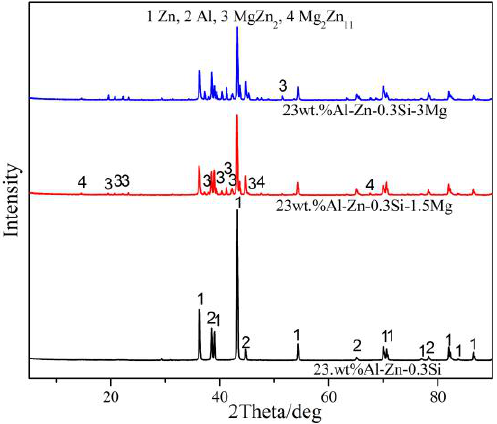
Figure 5. X-ray diffraction pattern of 23AZS– x Mg ( x = 0, 1.5, 3).